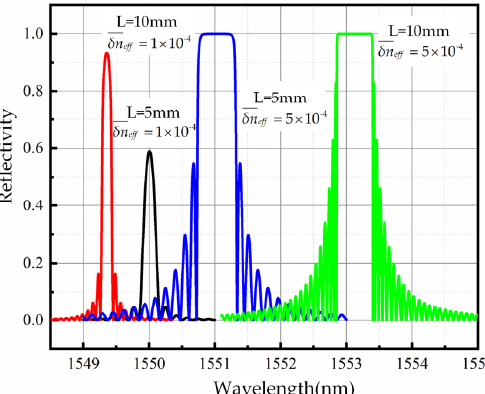
Figure 2. Reflection spectra of FBG with different refractive index modulation depths and gate region lengths.